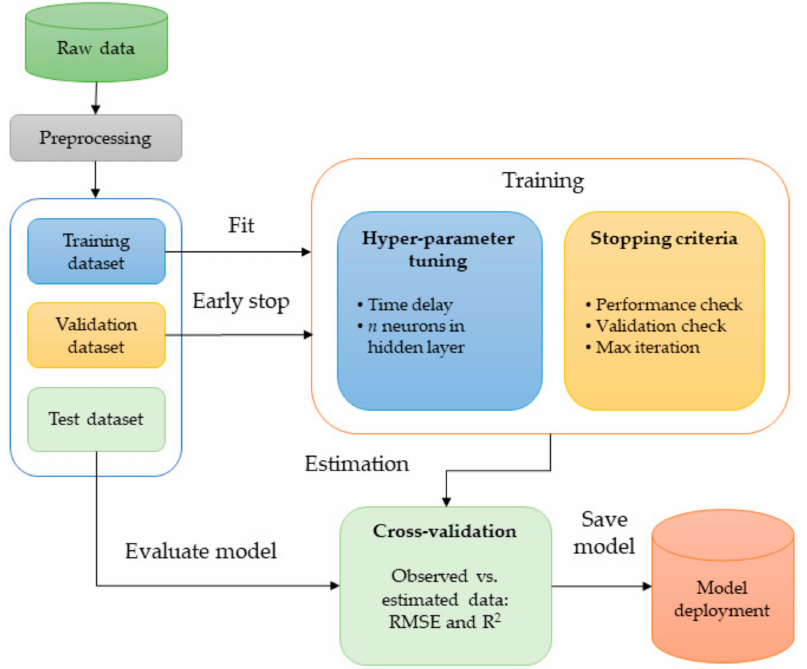
Figure 3. The workflow of model development using NARX neural